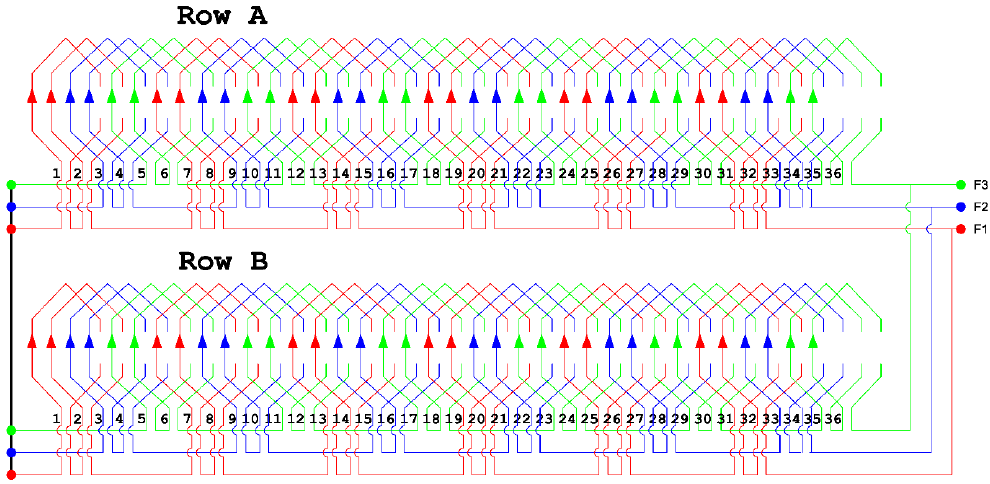
Figure 12. Alternative three-phase connection of the generator to remove the third harmonic.